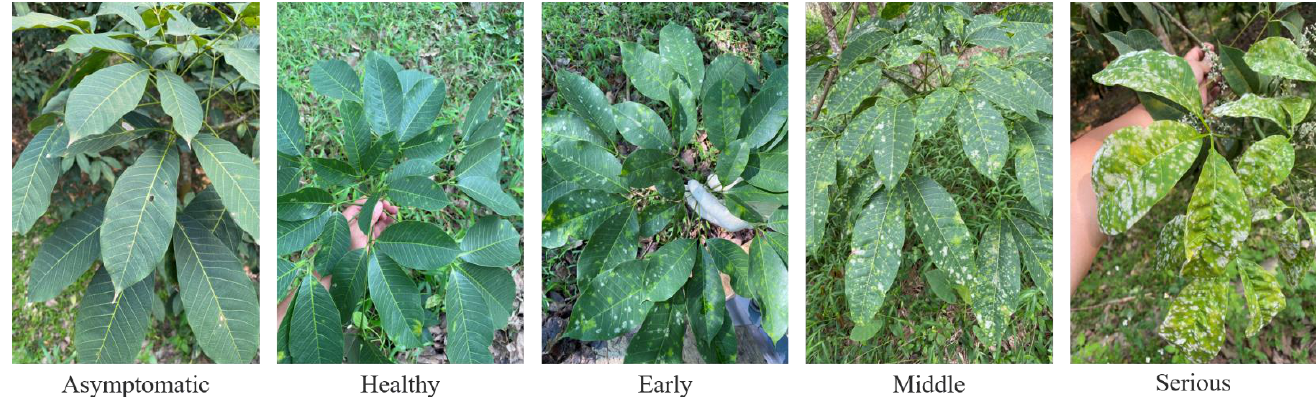
Table 1. Different stages of powdery mildew infection in rubber tree canopies.